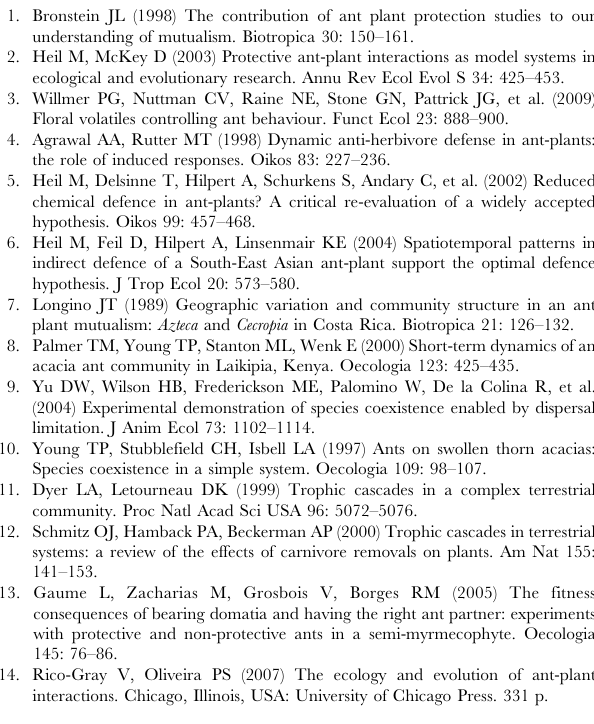
Table S1 Primary studies included in meta-analysis and effect